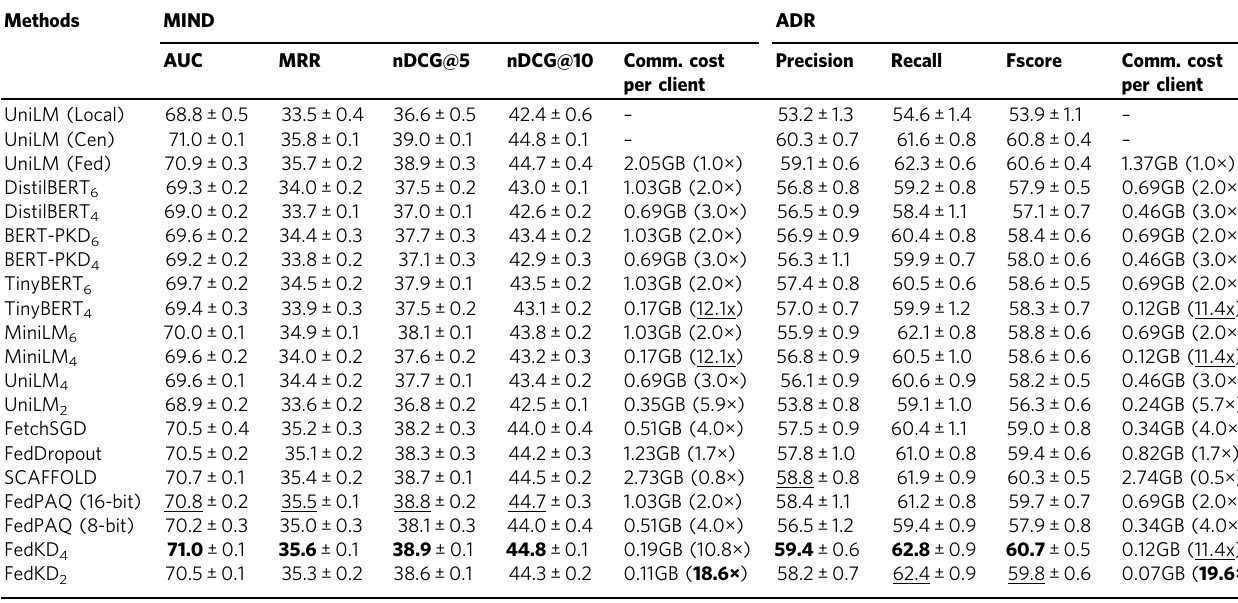
Table 1 Performance (with standard deviations) and communication cost per client of different methods on MIND and ADR.